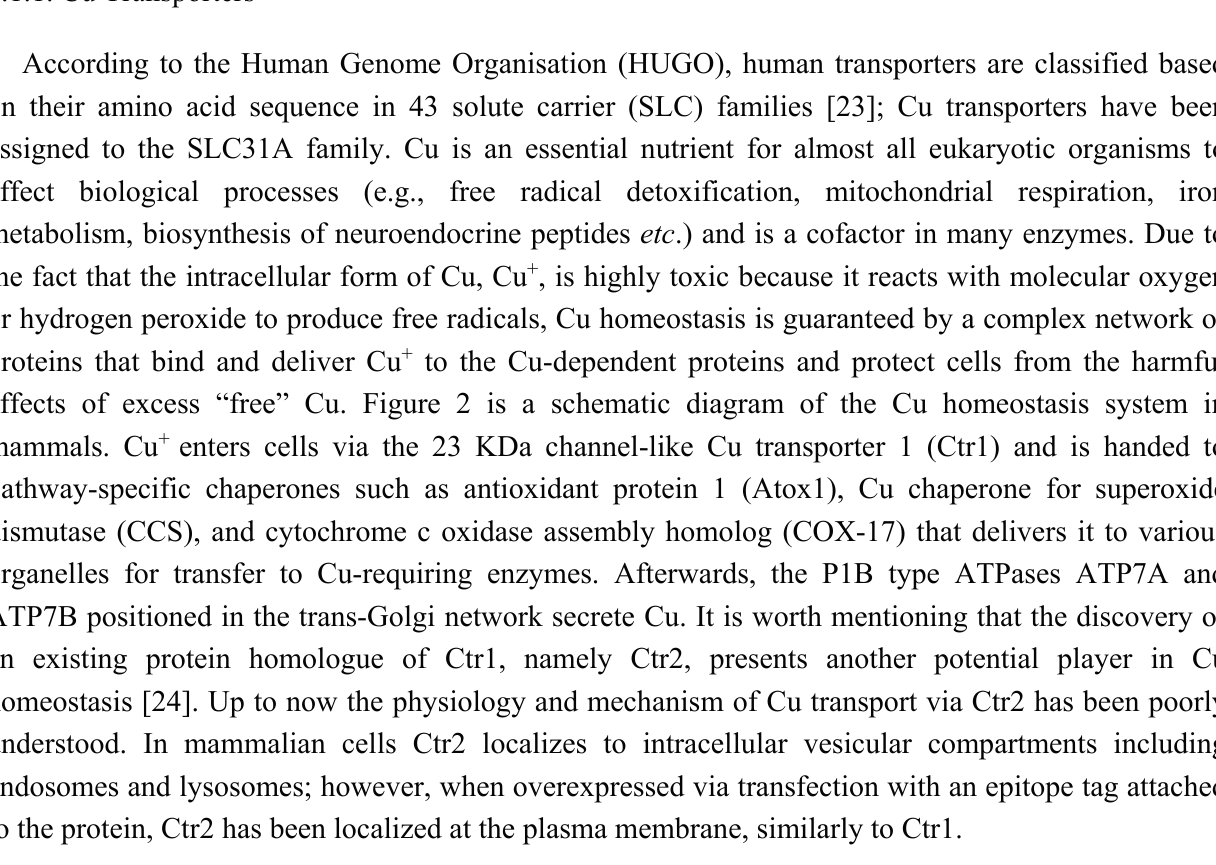
Figure 2. Schematic drawing of the major intracellular human Cu trafficking